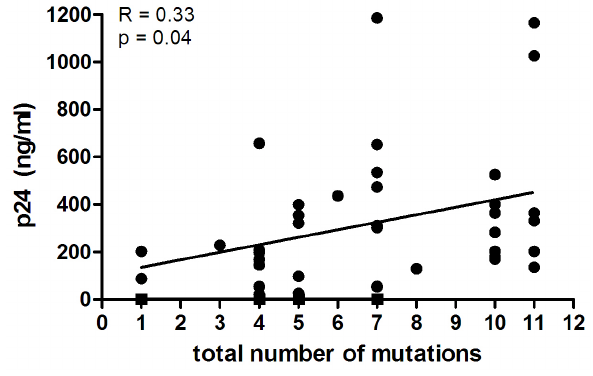
Figure 2. Accumulation of mutations in Gag correlates with a higher replication fitness. Spearman correlation analysis of the total number of escape and compensatory mutations associated with HLA- B*57/58:01 and the maximum p24 value observed for biological HIV-1 variants obtained from HLA-B*57/58:01 progressors and LTNPs in an in vitro replication assay.